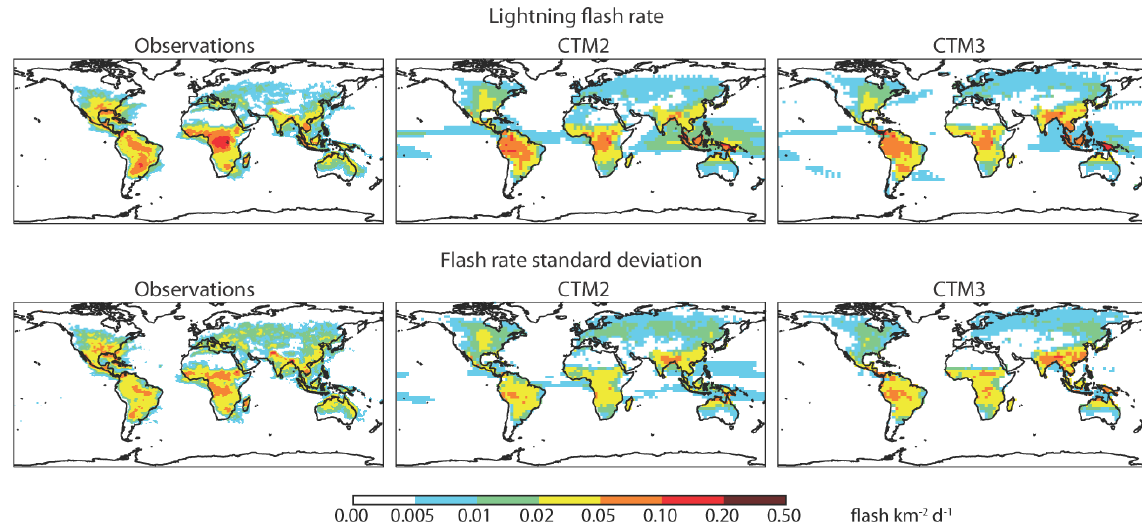
Fig. 1. Climatology of lightning flashes in observations and models. Annual mean flash rate (top) and standard deviation of monthly flash rates (bottom). Observation panels show OTD-LIS during 1995–2005. Model panels show Oslo CTM2 and Oslo CTM3 for